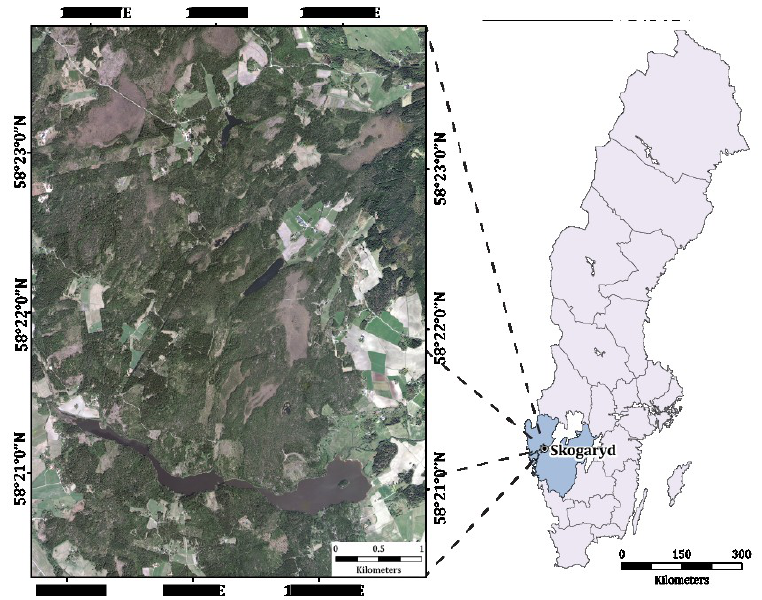
Figure 1. Map of Sweden, divided into counties, showing the location of the Skogaryd Research Catchment; the RGB orthophoto on the left details the study